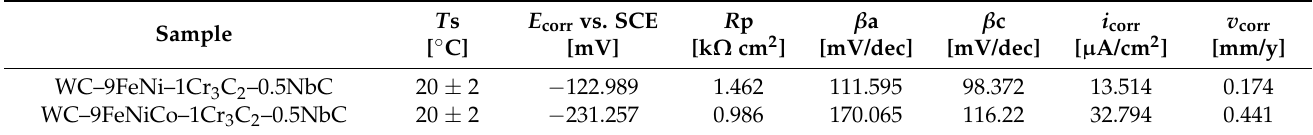
Table 4. The results of electrochemical DC